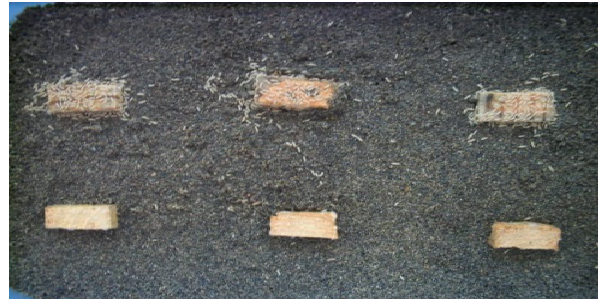
Figure 2. Termite aggregations on sound ( upper blocks ) and decayed ( lower blocks ) specimens of the same stake after the first 3 days of the choice feeding test. This aggregation pattern persisted until the end of the 14-day exposure period.